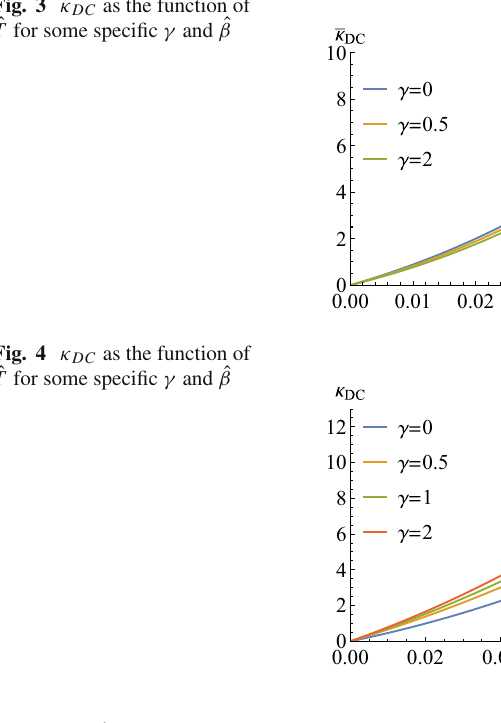
Fig. 4 κ DC as the function of ˆ T for some specific γ and ˆ